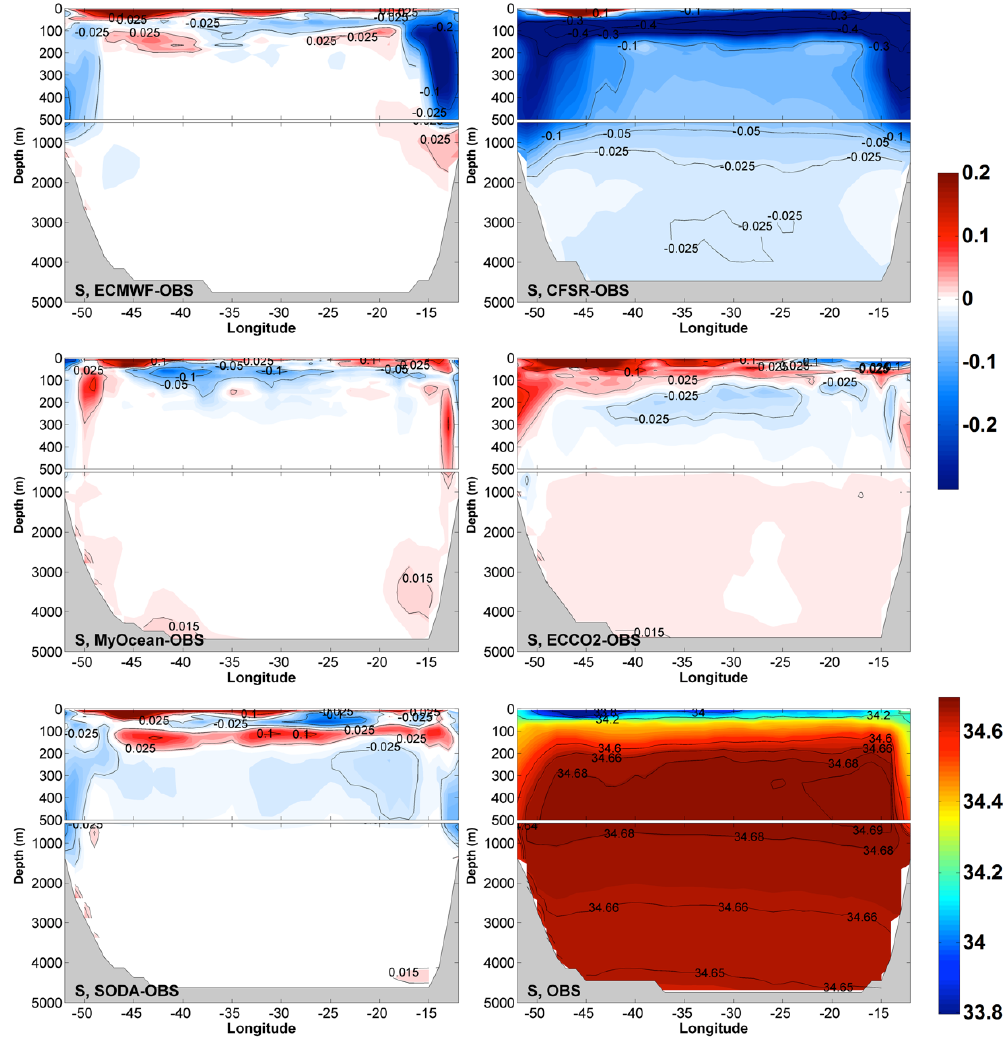
Figure 7. Same as in Fig. 6, but for section WOCE SR4. 1109